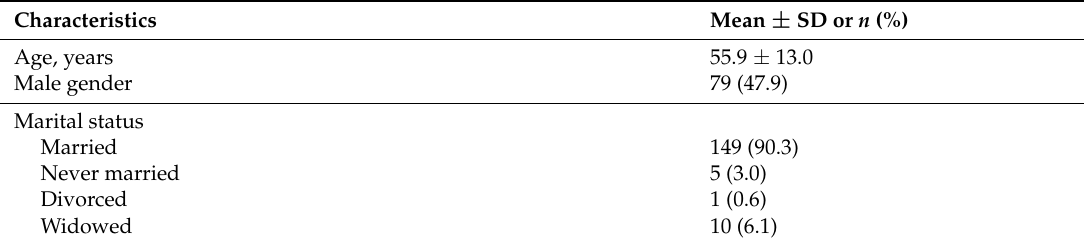
Table 1. Characteristics of the participants ( n =